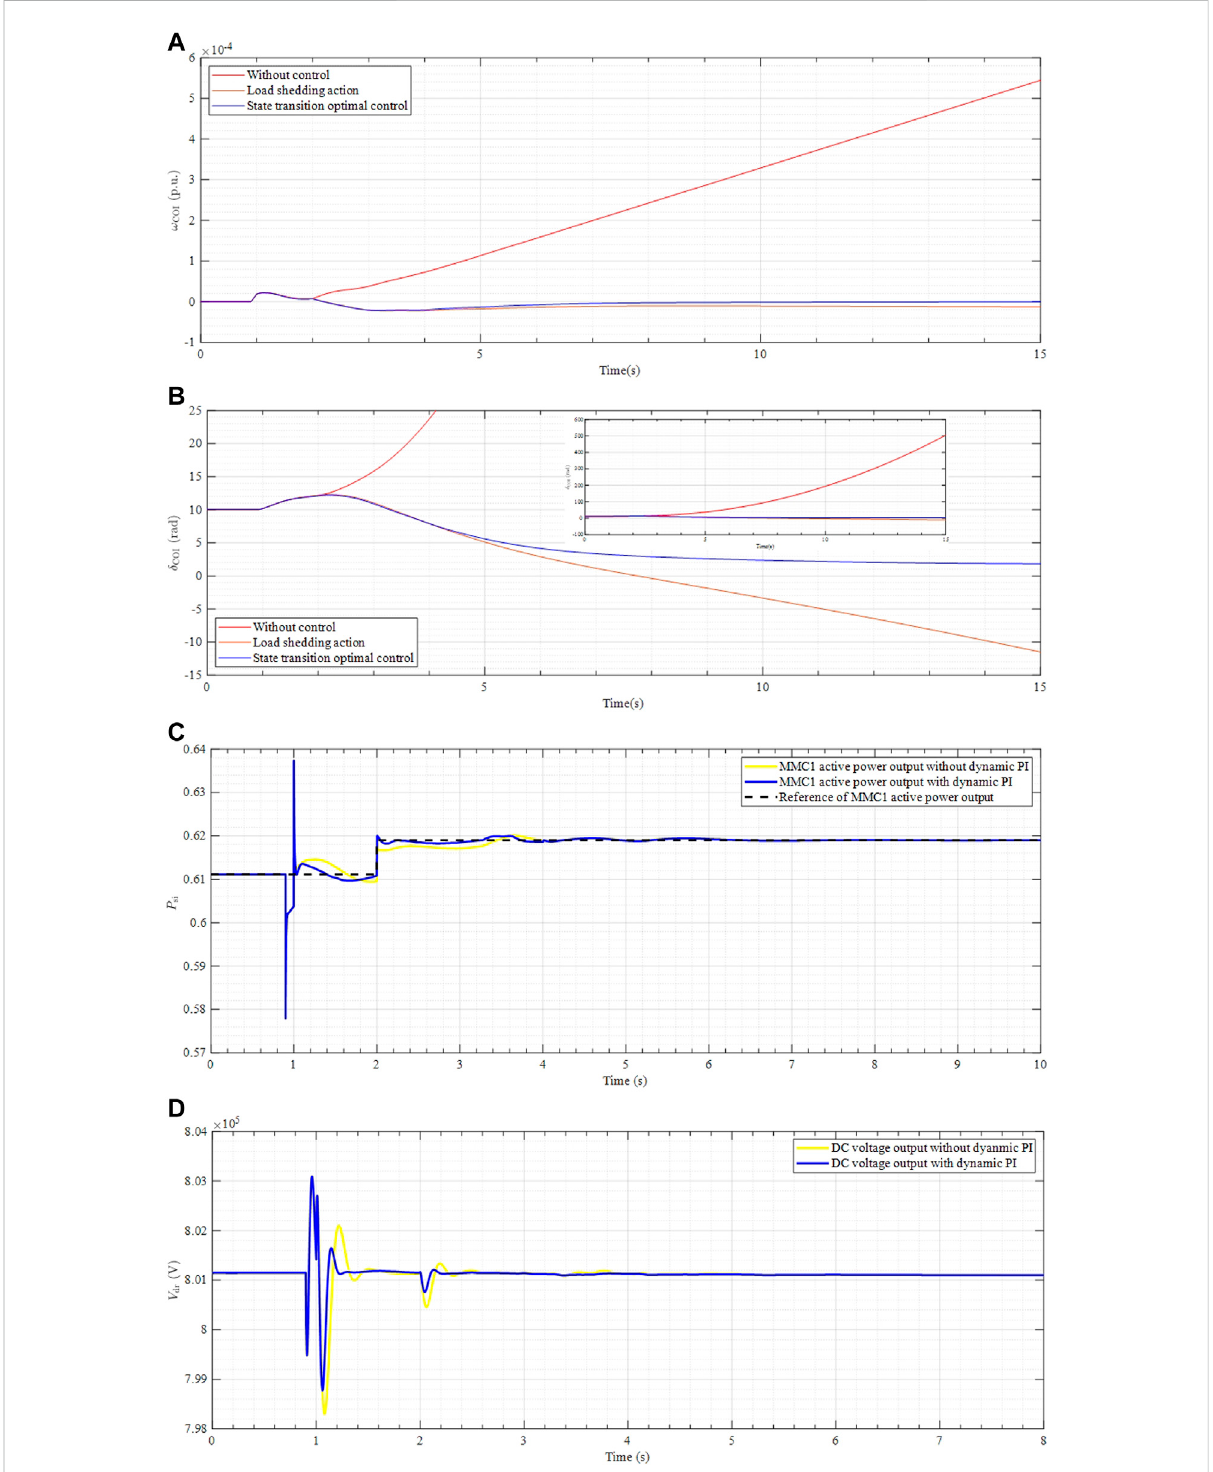
FIGURE 6 Dynamicofthe10-machine39-bussysteminthecasewhenN-2contingencyoccurs. (A) Anglespeedofthecenterofinertia. (B) Rotorangleof the center of inertia. (C) Active power output of the inverter-side MMC. (D) DC voltage output of the recti fi er-side